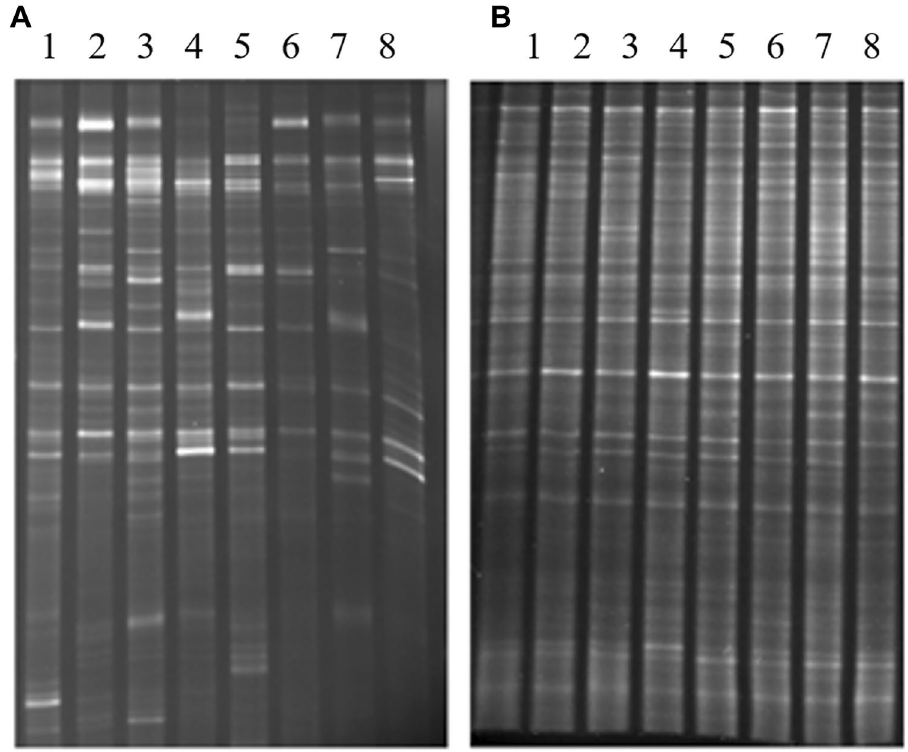
Figure 1. DGGE maps of fungal ( A ) and bacterial ( B ) communities. A DGGE map of bacterial community; B DGGE map of fungal community; 1: AM M 0 mM; 2: AM M 75 mM; 3: AM F 0 mM; 4: AM F 75 mM; 5: